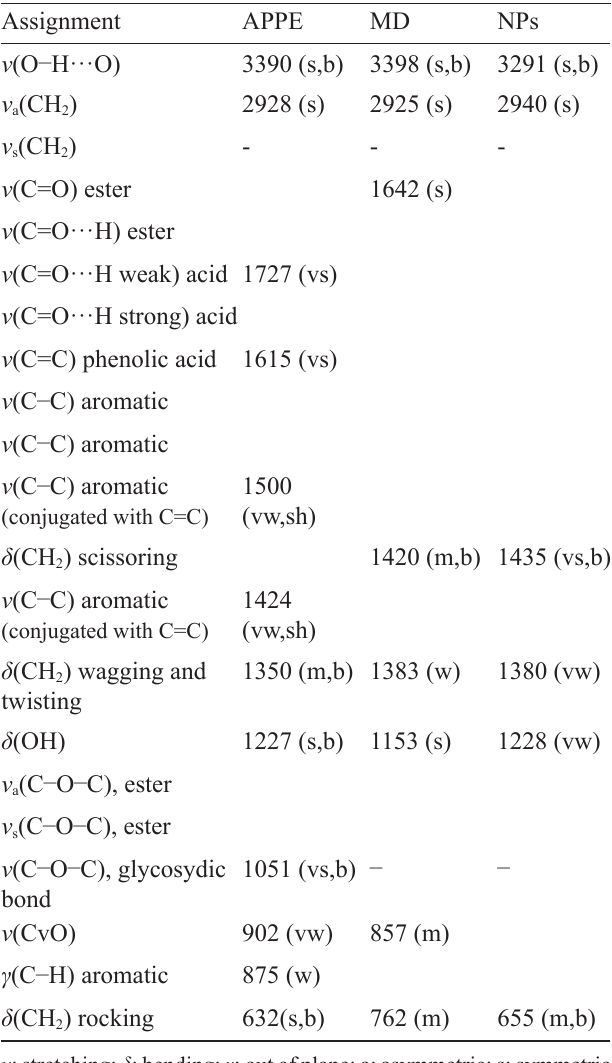
Table 3. FT-IR major peaks assignments of the APPE, the MD and the loaded